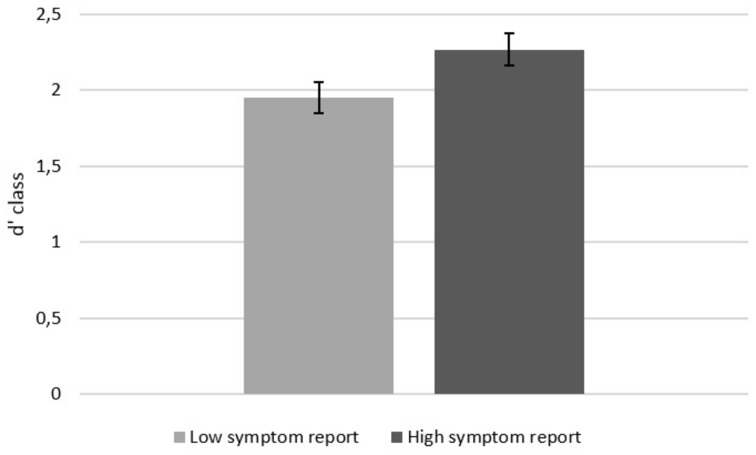
Accuracy in classifying loads as belonging to A or B. Error bars represent standard errors of the mean.